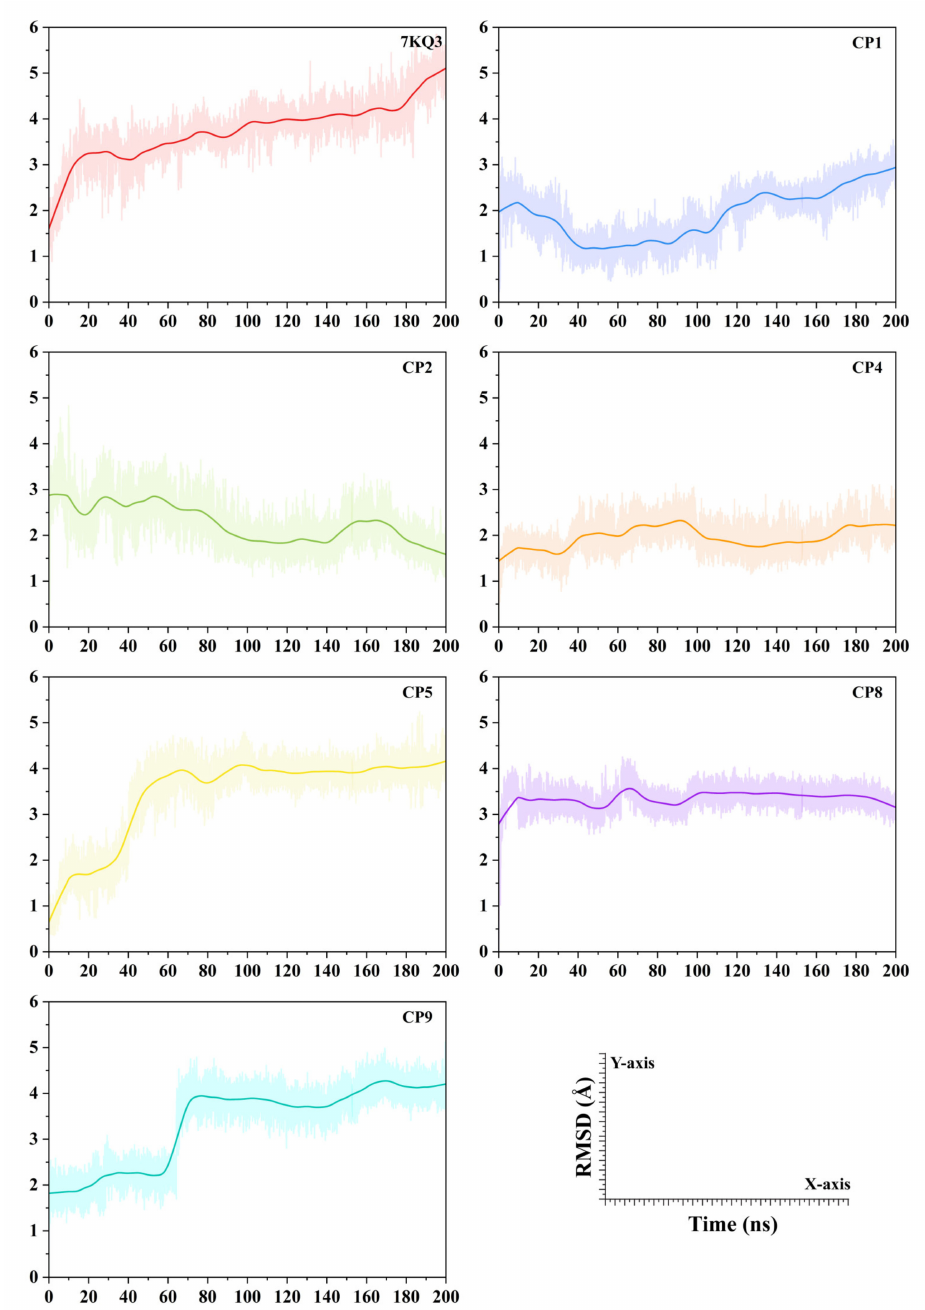
Figure 3. Ligands stability analyzed via root mean square deviation (RMSD) complex with Isla protein with reference attached system